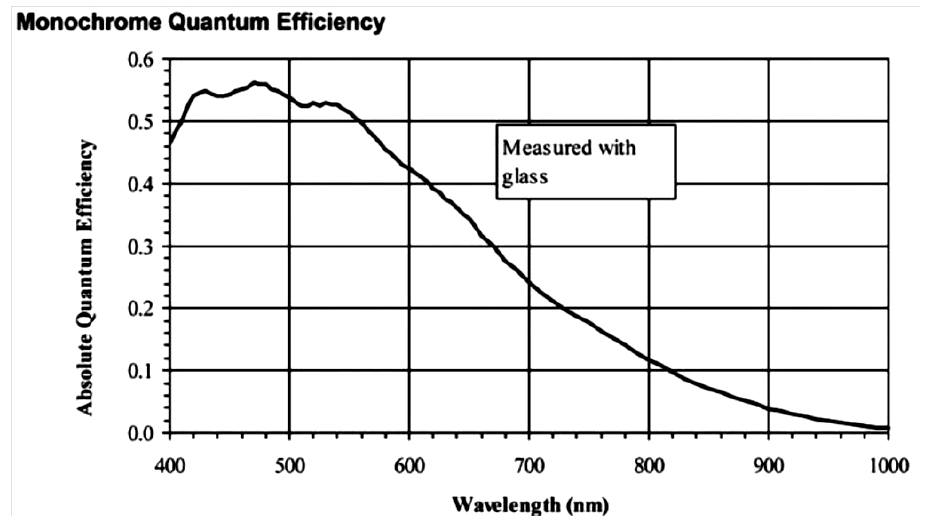
Figure 3. QE of typical Si based camera.